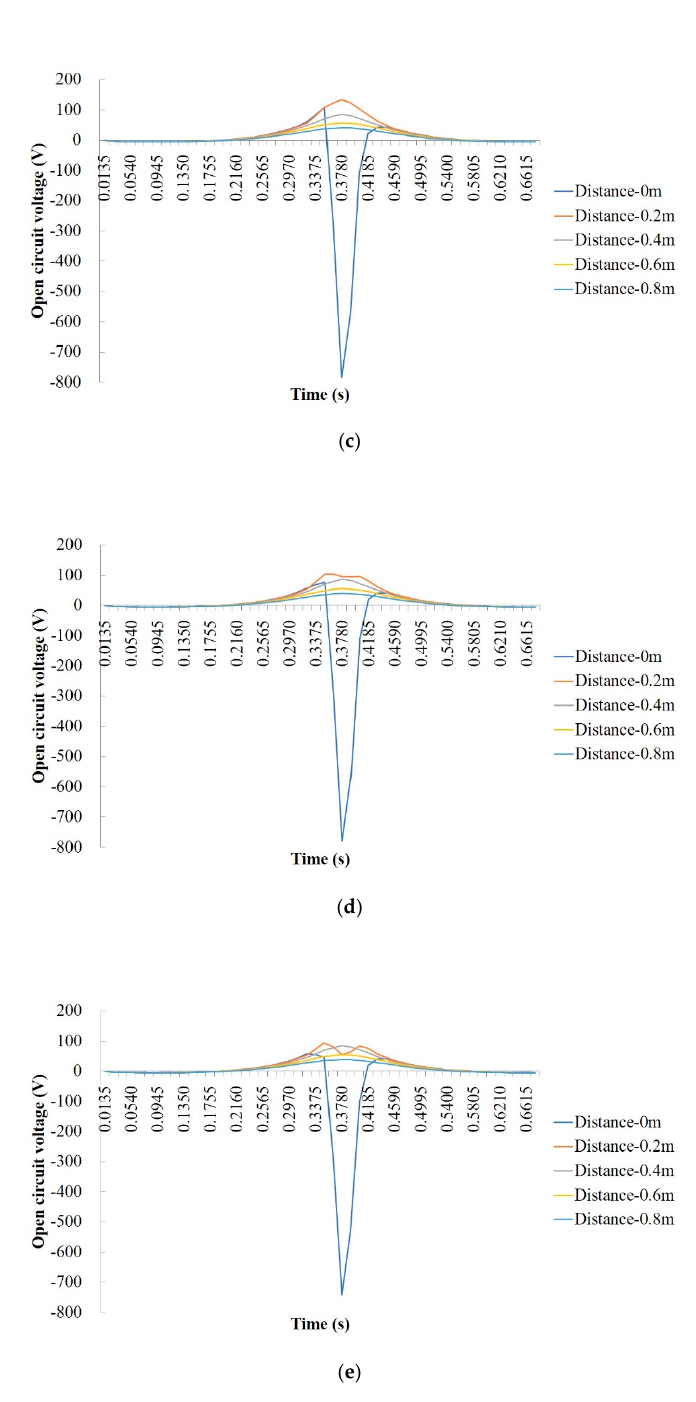
Figure 5. Open circuit voltage response of PEH at different horizontal loading distances and buried depths: ( a ) buried depth of 2 cm; ( b ) buried depth of 4 cm; ( c ) buried depth of 6 cm; ( d ) buried depth of 8 cm; ( e ) buried depth of 10 cm.